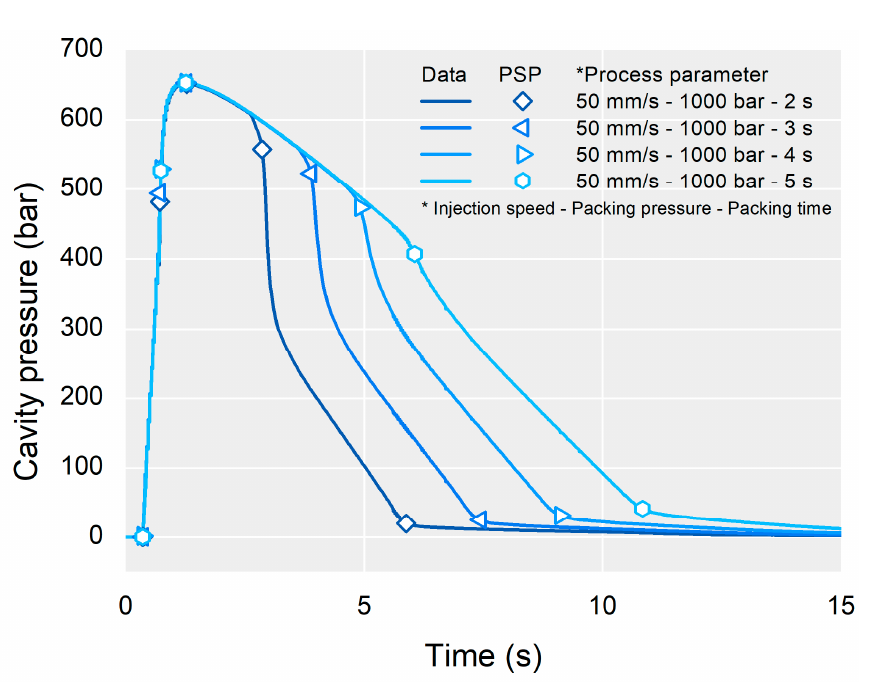
Figure 6. Example of the extraction of the process state points (PSP).